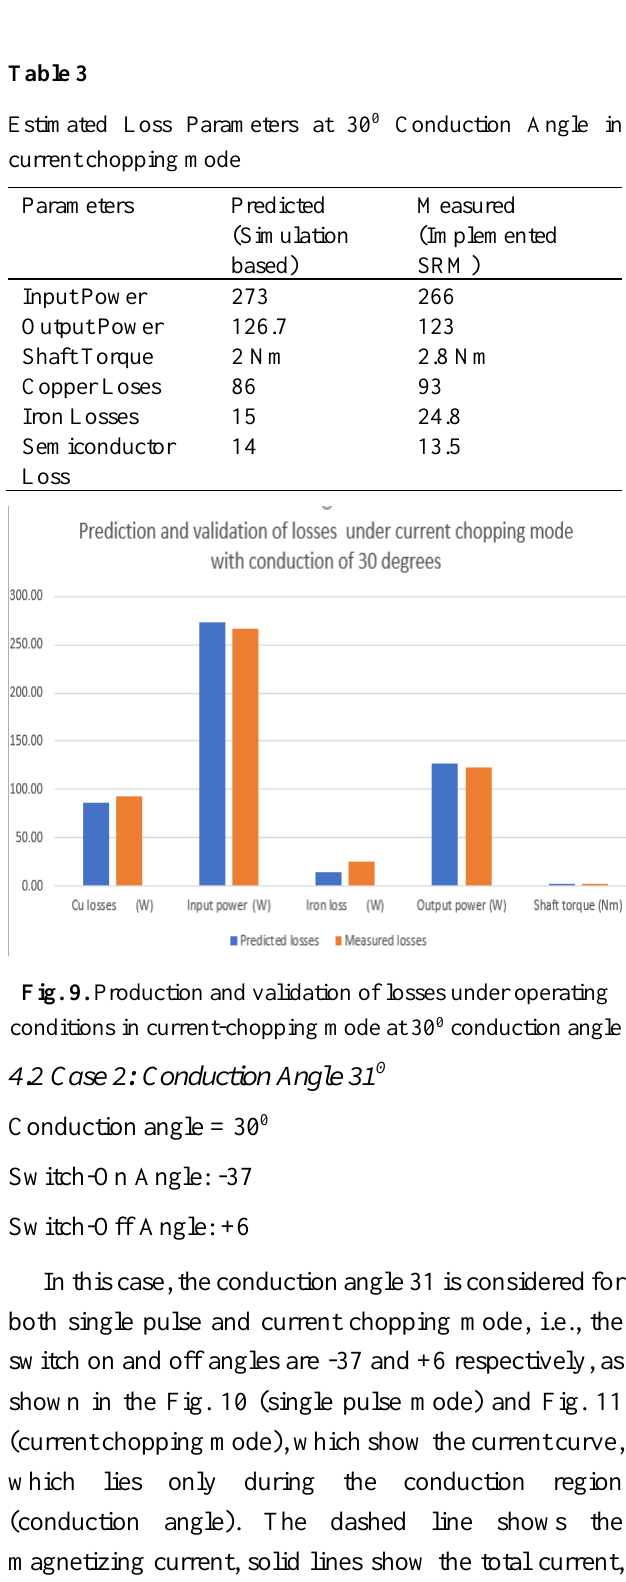
Fig. 8. Representation of current waveforms in current chopping mode at conduction angle of 30 degrees